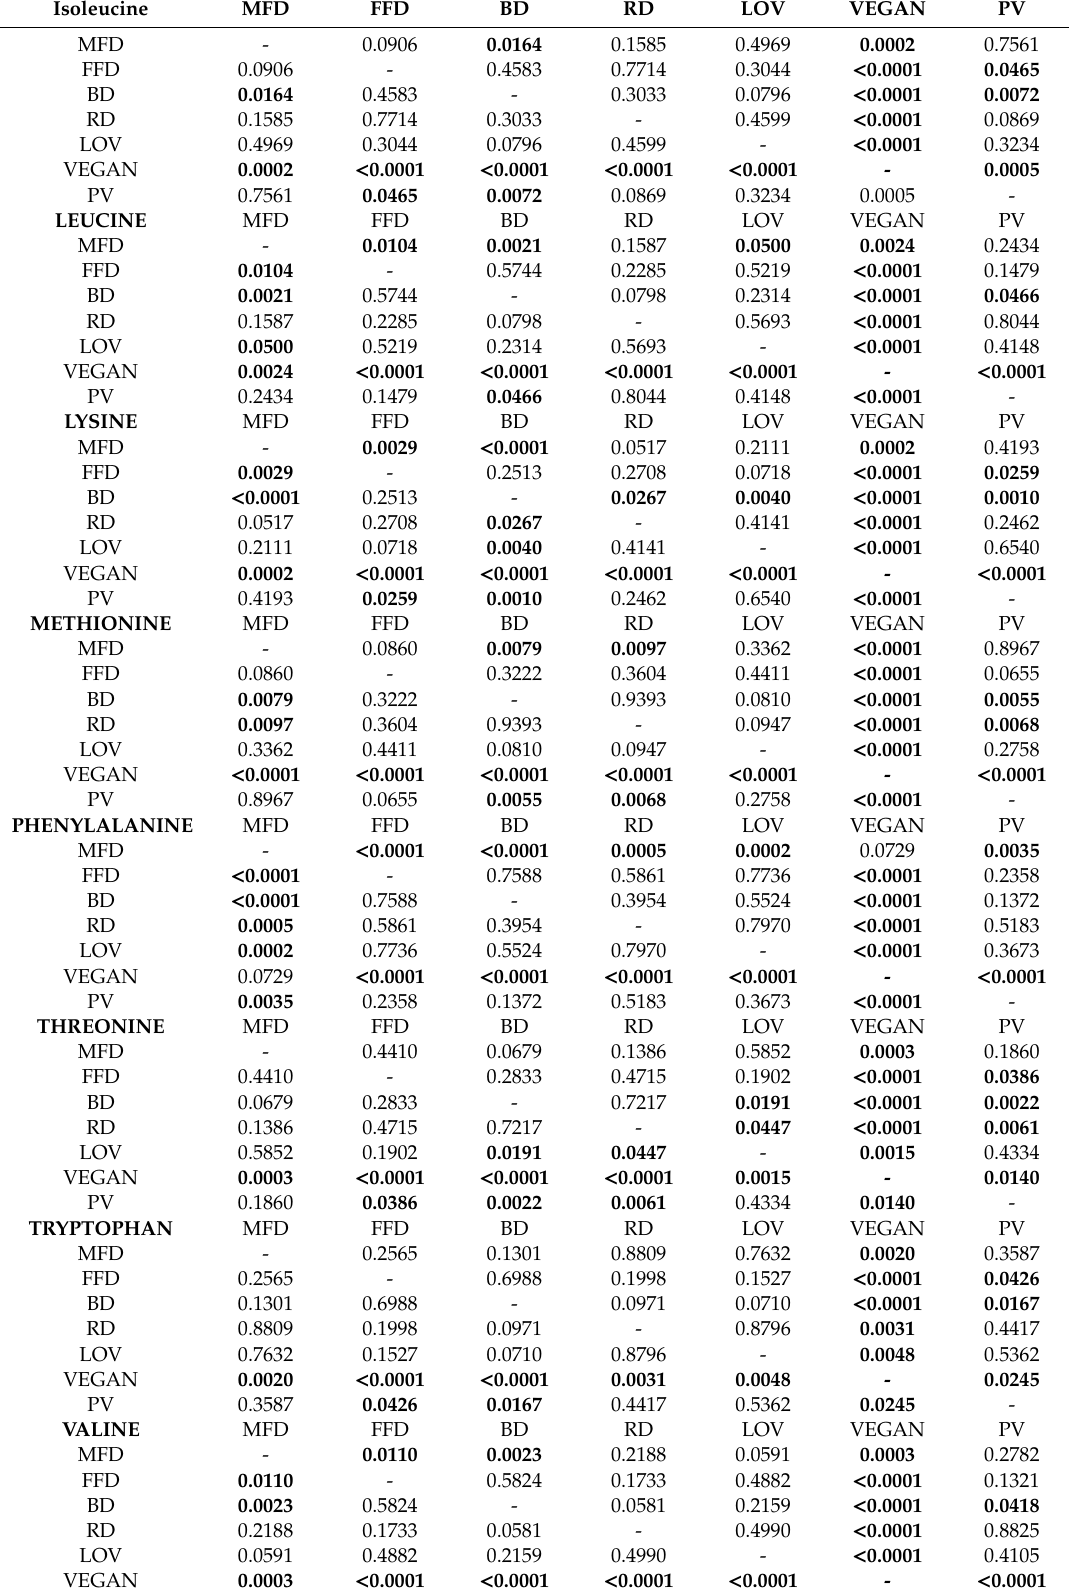
Table 4. The di ff erences in the content of exogenous amino